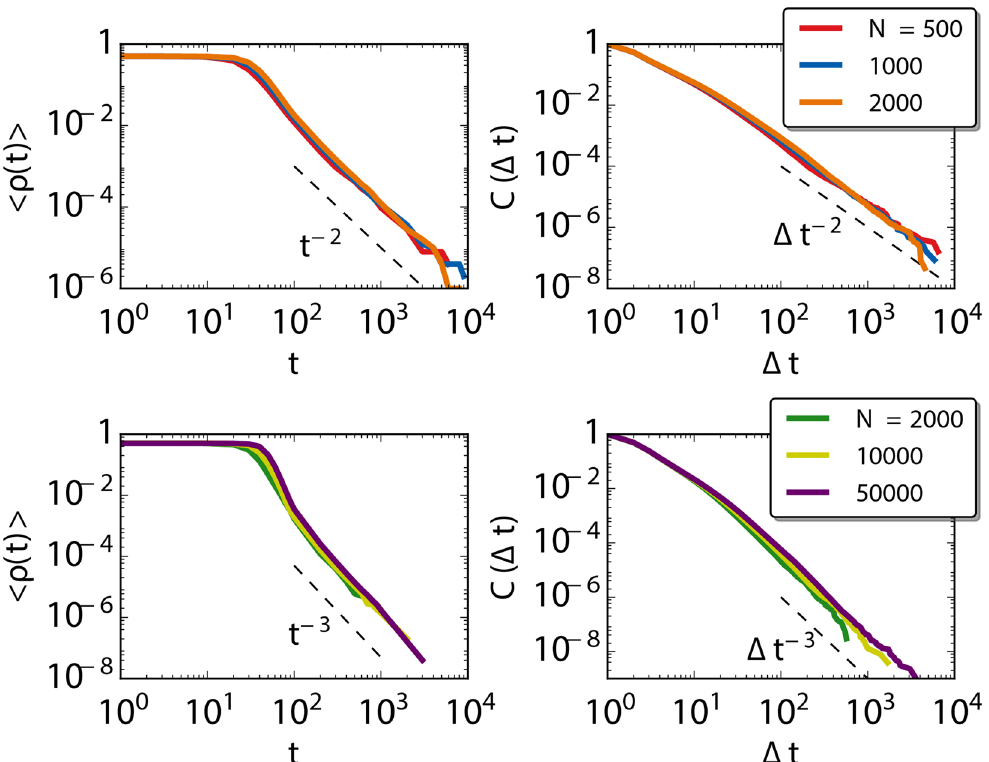
Figure 3. Average fraction of active links as a function of time 〈 ρ ( t ) 〉 and cumulative inter-event time distribution C ( Δ t ) for a fully connected network with q = 1 and for different values of the activation coefficients. At the top b 1 = b 2 = 1. At the bottom b 1 = 1 and b 2 = 2. The tails of both functions decay as power-laws with exponent b 1 + b 2 . The curves are averaged over 1000